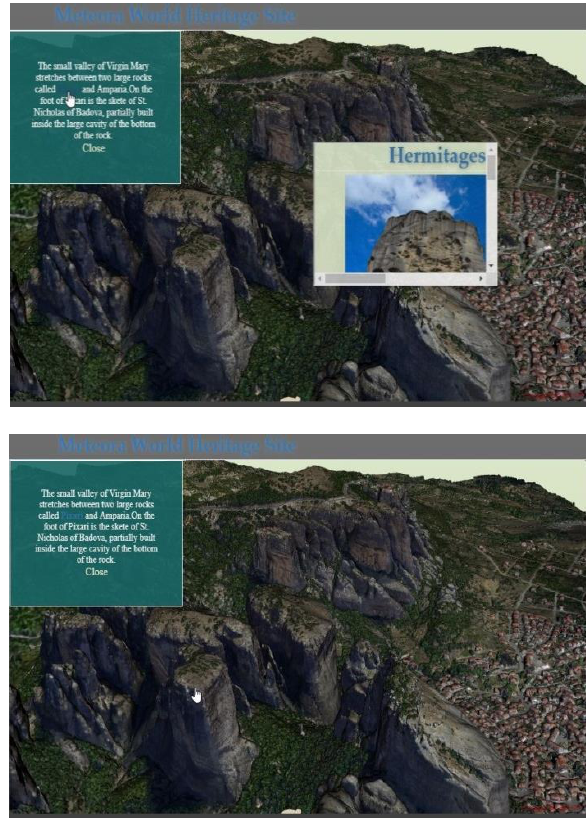
Figure 5. Snapshots during the investigation of the 3D scene of Meteora; in the dialog box, the word Pixari in the description is a link to the 3D visualization of Pixari model and a frame is used for preview.